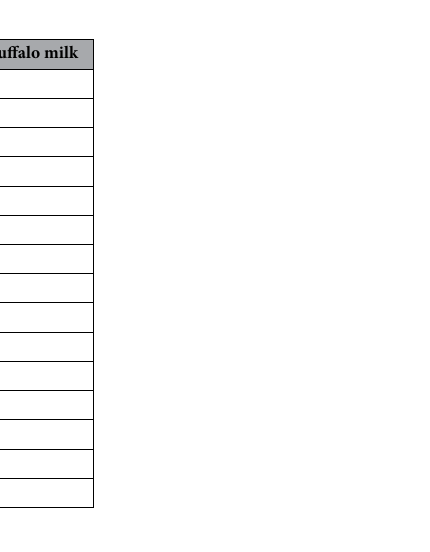
Table 1. The lipidome of water buffalo